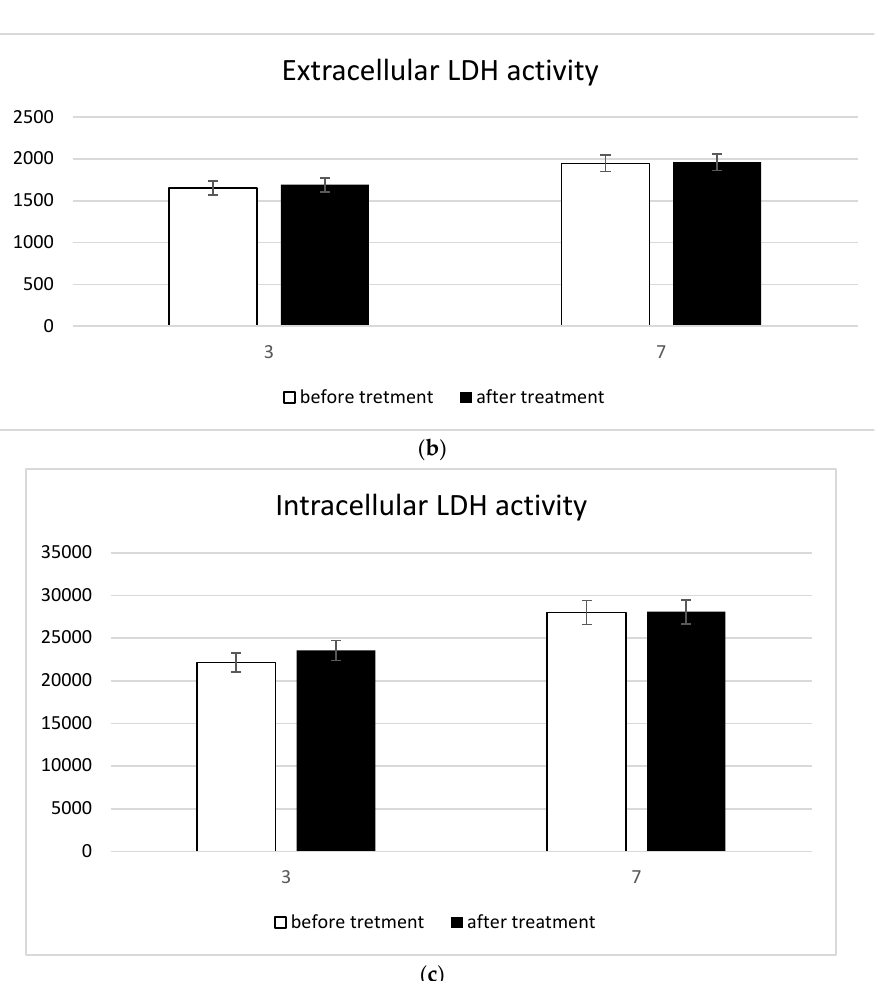
Figure 3. Cell integrity detection: ( a ) MTT assay; ( b ) extracellular LDH; and ( c ) intracellular LDH. SEM images showed the presence of a layer of calcified matrix on the osteogenic differentiated cells (yellow circle in Figure 4a). After the treatment, the calcification disappeared, and the cells on the top of the membrane were evident (Figure 4b). The treatment induced the release of the calcific component, leaving cells with a typical mesenchymal-endothelial phenotype. The release of the calcific matrix was assessed by ARS assay (Figure 4c). The amount of calcium resulting from the calcification process was markedly greater following treatment.